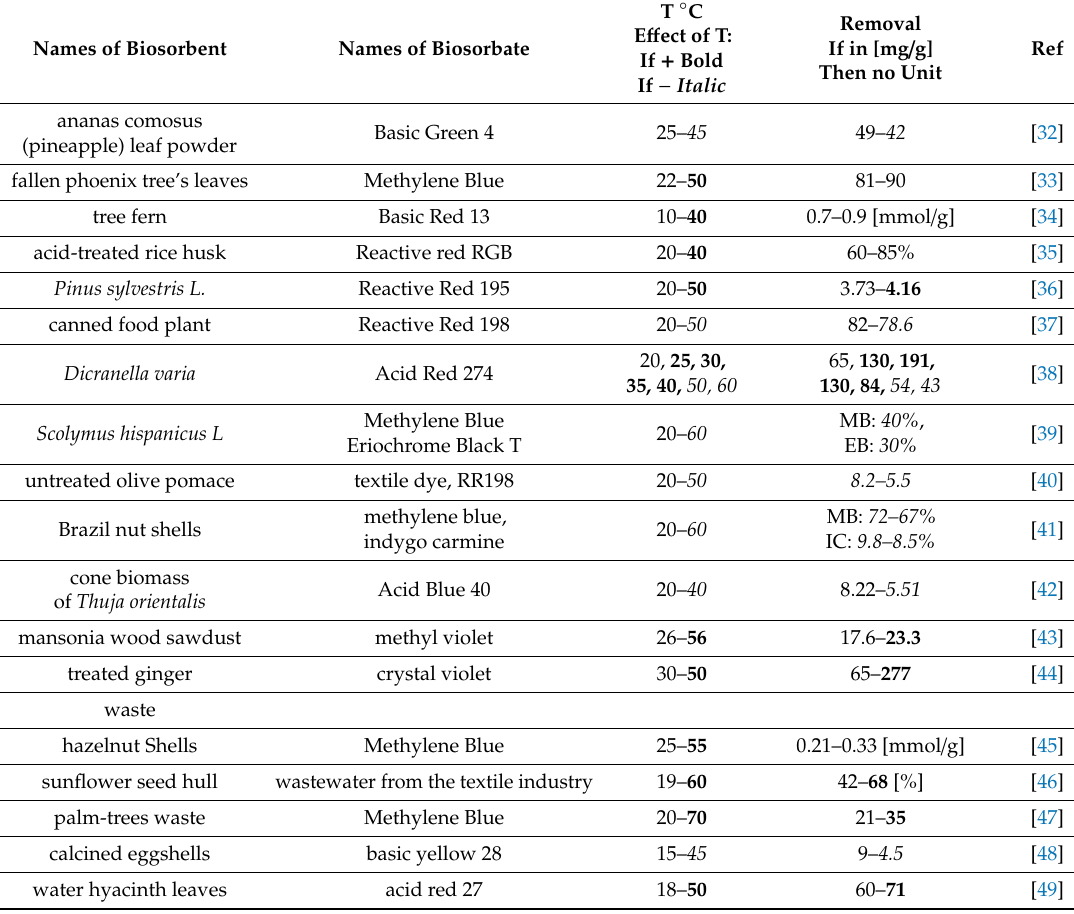
Table 3. Influence of temperature on the biosorption of dyes by other